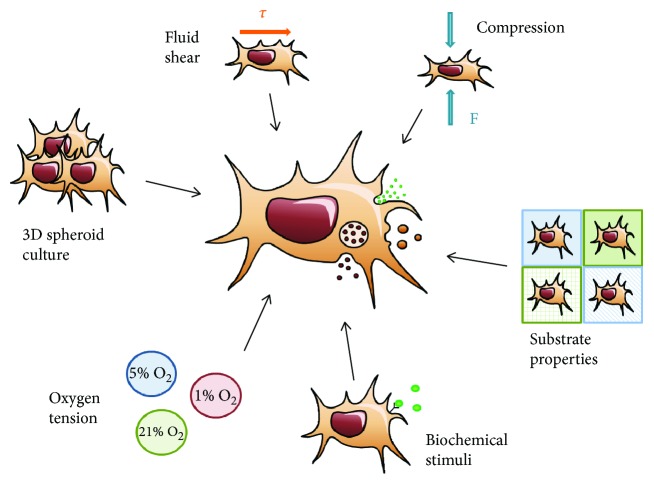
Alterations to MSC cultures reported to have an influence on the MSC secretome profile. 3D spheroid culture (i.e., forced cell-cell interactions), fluid shear, compression forces, the properties of the cells' residing substrate (i.e., stiffness and topography), biochemical stimuli (i.e., exposure to inflammatory factors), and the amount of oxygen cells are exposed to influence the amount and types of biomolecules secreted by MSCs.